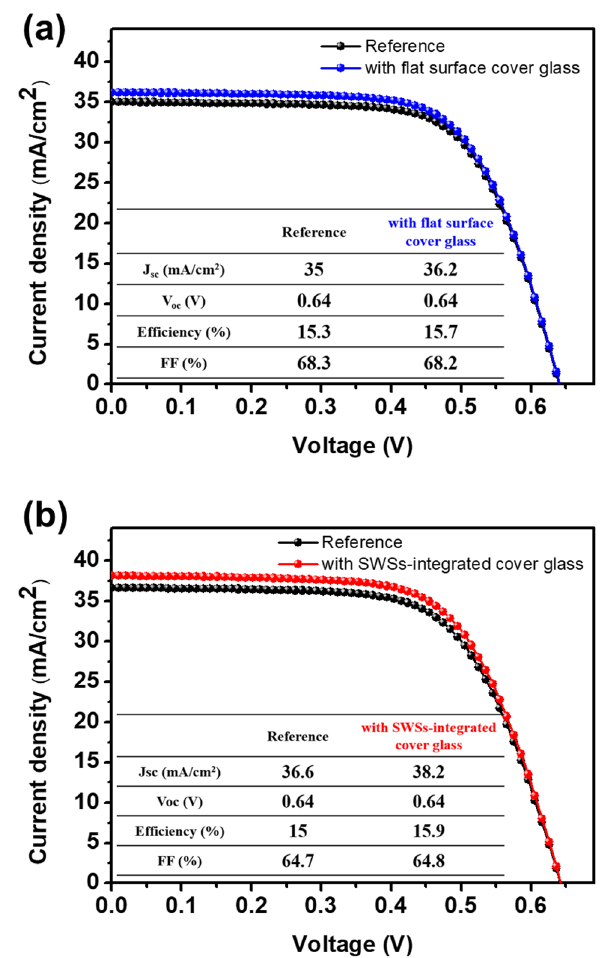
Figure 6. Current density–voltage curves of the CIGS devices with ( a ) the flat surface glass and ( b ) the SWS-integrated cover glass, as compared with those of the reference devices.